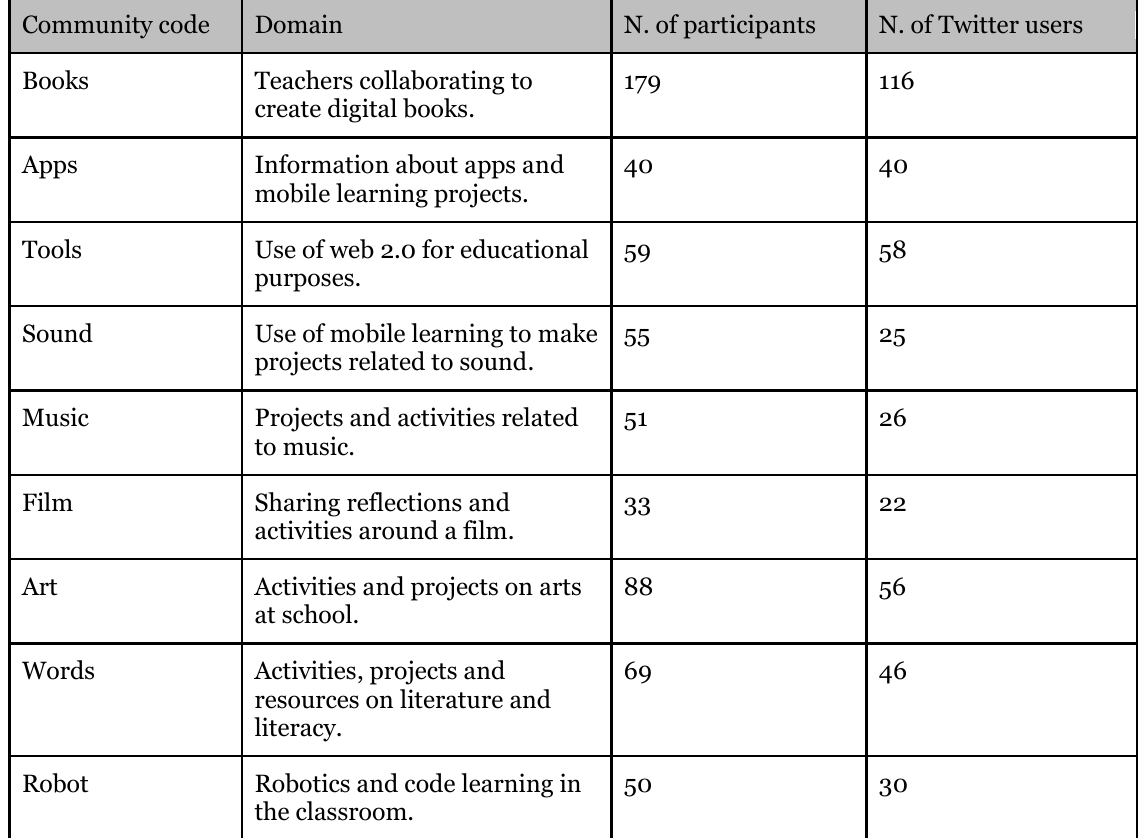
Characteristics of the Selected Communities Community code Domain N. of participants N. of Twitter